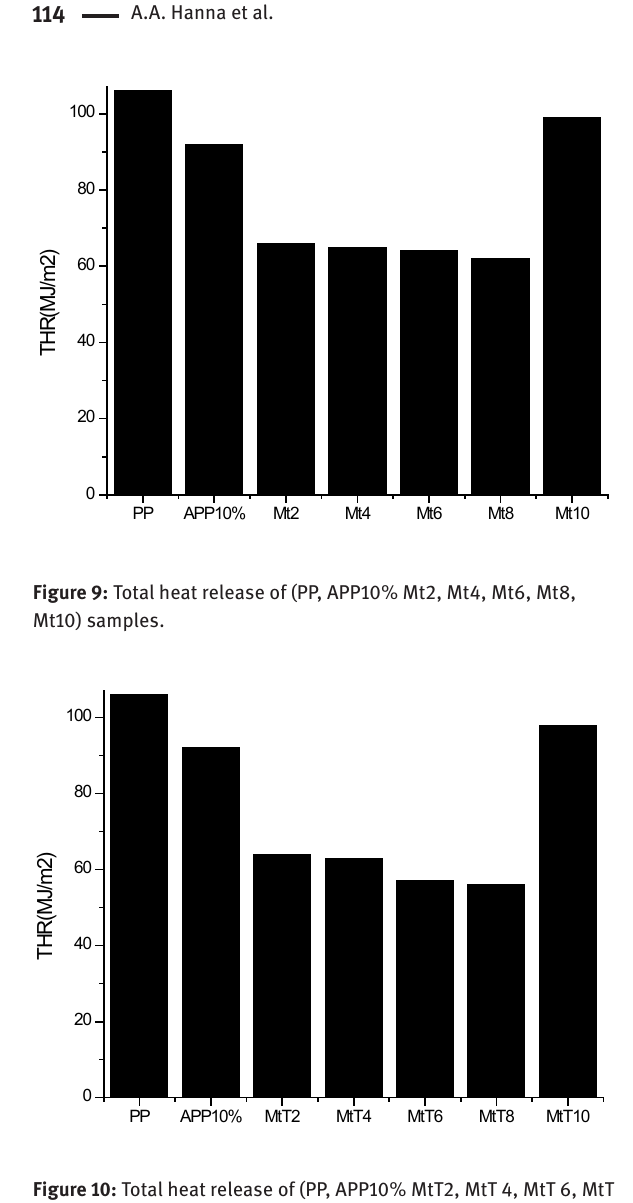
Figure 10: Total heat release of (PP, APP10% MtT2, MtT 4, MtT 6, MtT 8, MtT 10)